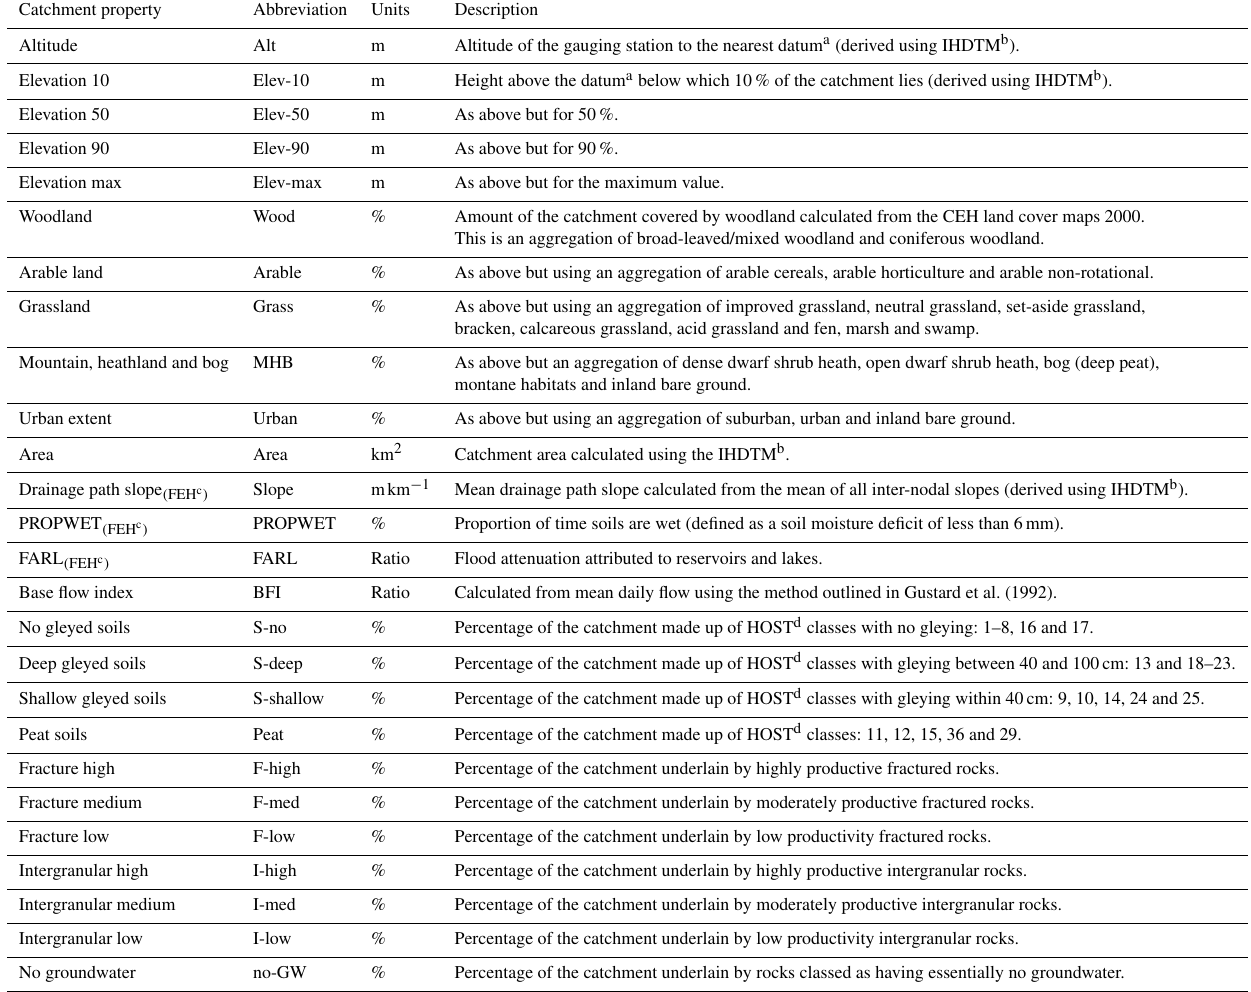
Table 1. Summary of catchment properties used (after Chiverton et al., 2015a). Catchment